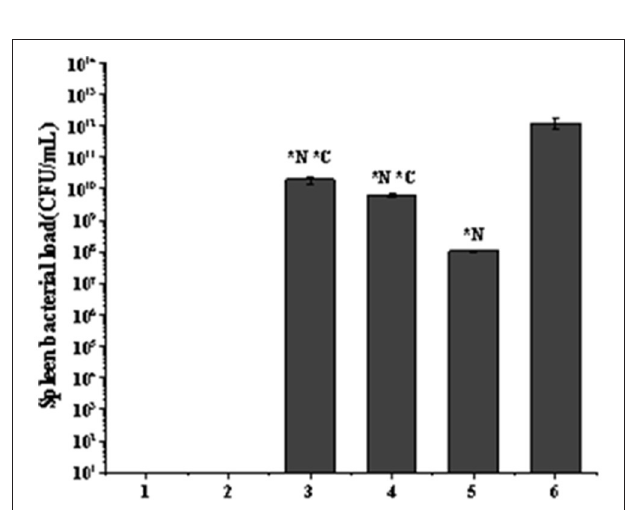
FIGURE 9 | Hematoxylin–eosin staining microscopy of spleen and brain ( × 400). Black arrow in the figure indicates the location of the lesion. Compared with the blank control group, the non-intervention group showed partial splenic corpuscle disappearance from spleen; apoptosis of a large number of lymphocytes, accompanied by a certain degree of hemorrhage, and the boundary of the germinal center was blurred. Partial meningeal hyperemia, cerebral cortex tissue shows watery degeneration, and the nerve cells are necrotic and atrophied, which is typical of sepsis and